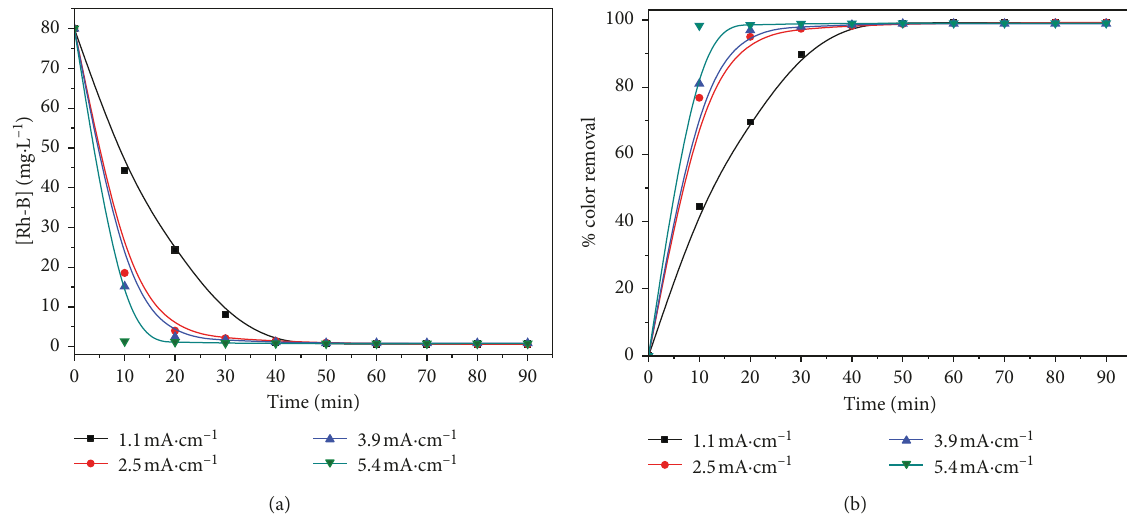
Figure 5: Effect of applied electrical current density on the electrodegradation of Rh-B. (a) Variation of concentration of Rh-B. (b) Color removal efficiency versus electrolysis time. Conditions: [NaCl], 0.07mol · L − 1 ; [Rh-B], 80mg · L − 1 ; T , 25 ° C; flow rate, 30L · h − 1 .